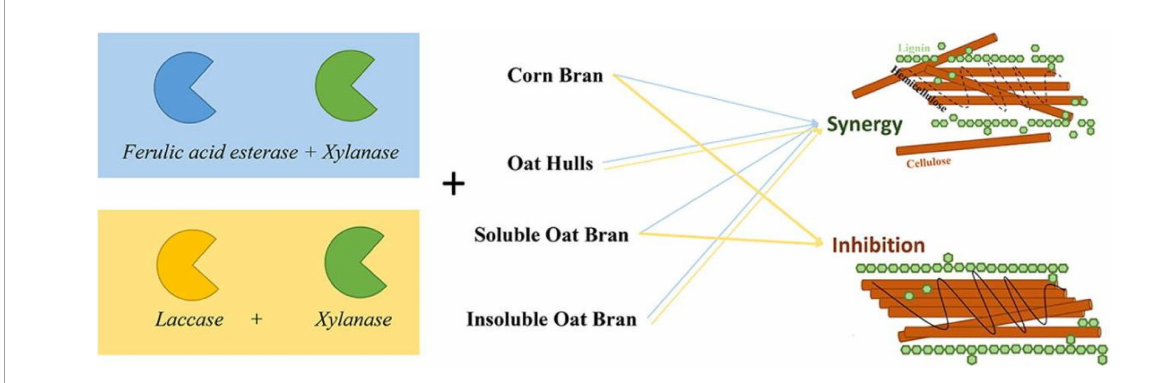
FIGURE4 Enzyme synergy for preparing XOS is highly substrate-dependent.